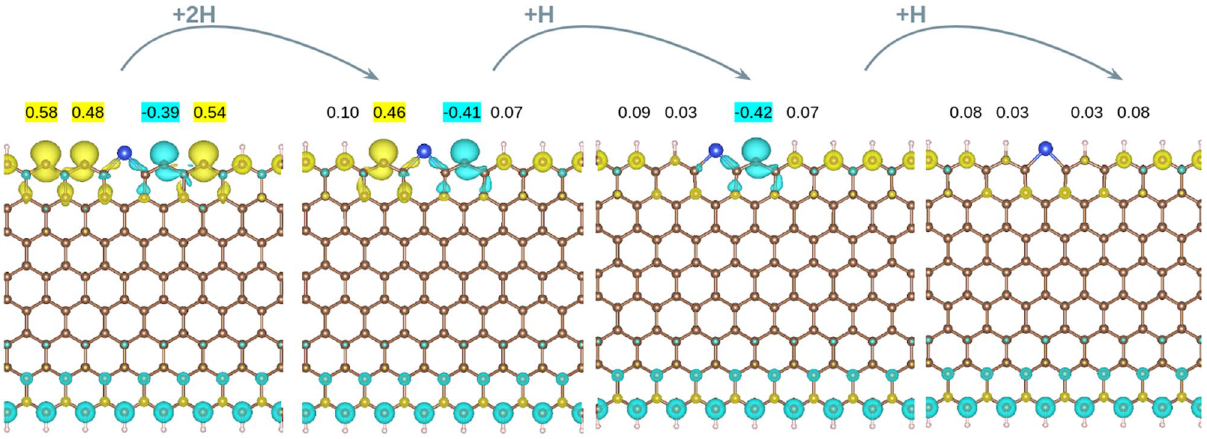
Figure 4. Spin density of S1 with one edge undoped and passivated with H atoms and the opposite edge partially passivated with a varying number of H atoms. Isosurface value of 0.005 e/ Å 3 . The values of the magnetic moments (in μ B ) of the C edge atoms are also shown. The values for yellow (α-spin) and blue (β-spin) isosurfaces are 0.005 e/ Å 3 . Carbon, silicon and hydrogen atoms are depicted in brown, blue and white,